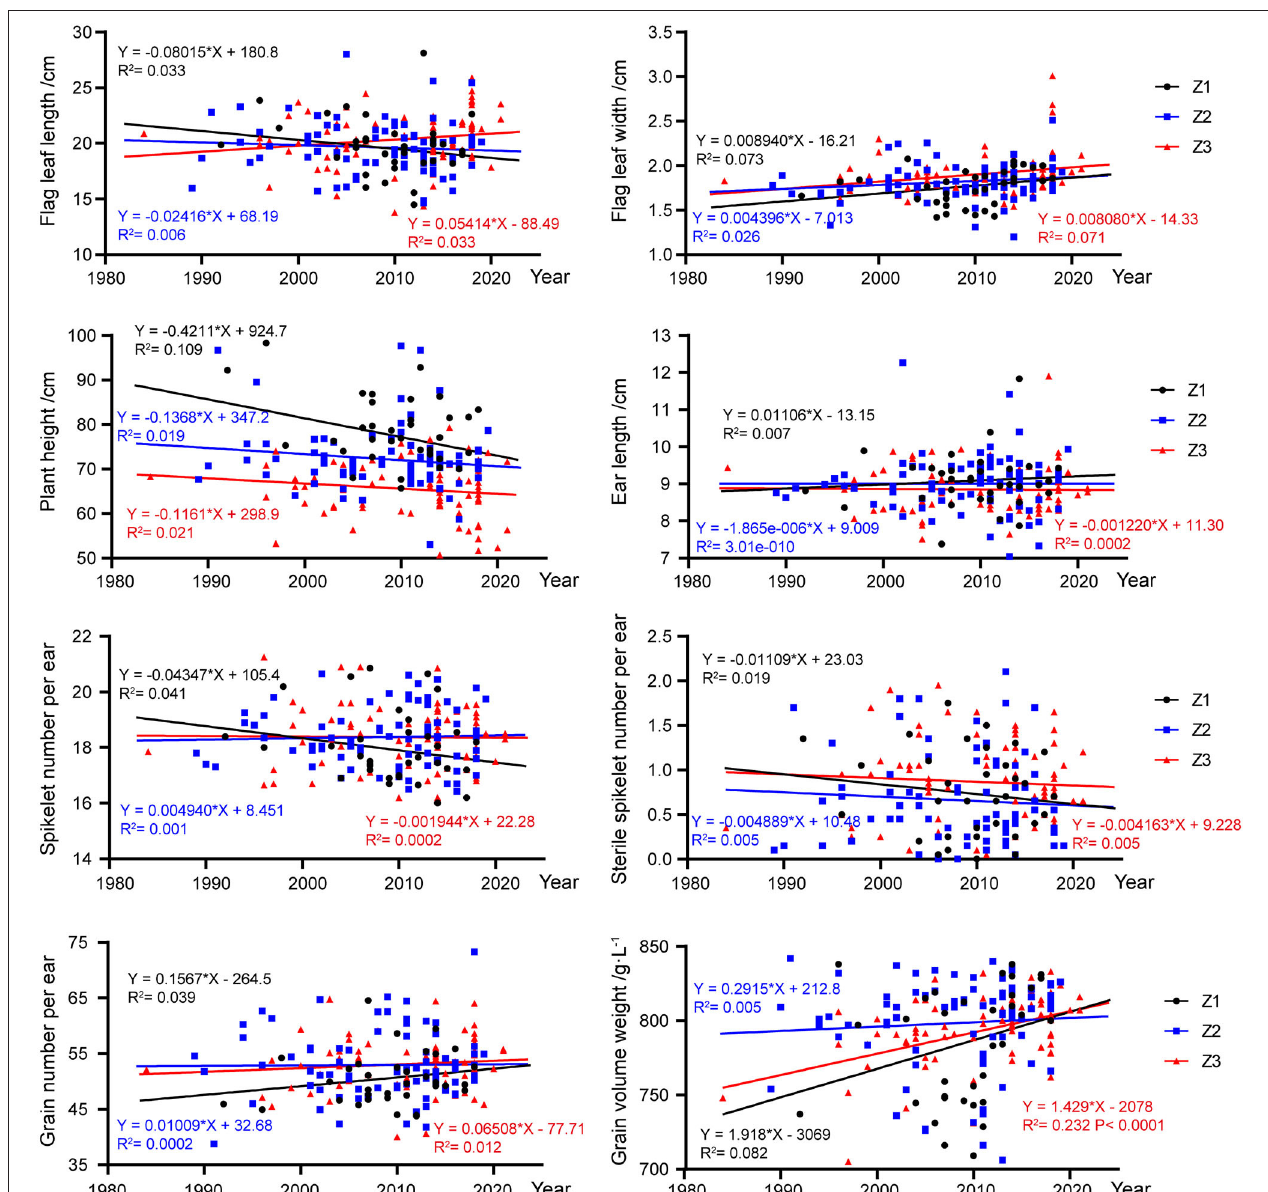
FIGURE 5 | Changes in eight measured characteristics of wheat varieties in different years and wheat areas. Circles, squares, and triangles represent wheat varieties from Z1, Z2, and Z3 zones, respectively. The fitted equations for the Z1, Z2, and Z3 zones are distinguished in black, blue and red, respectively. R ² represents the regression coefficient of each regression